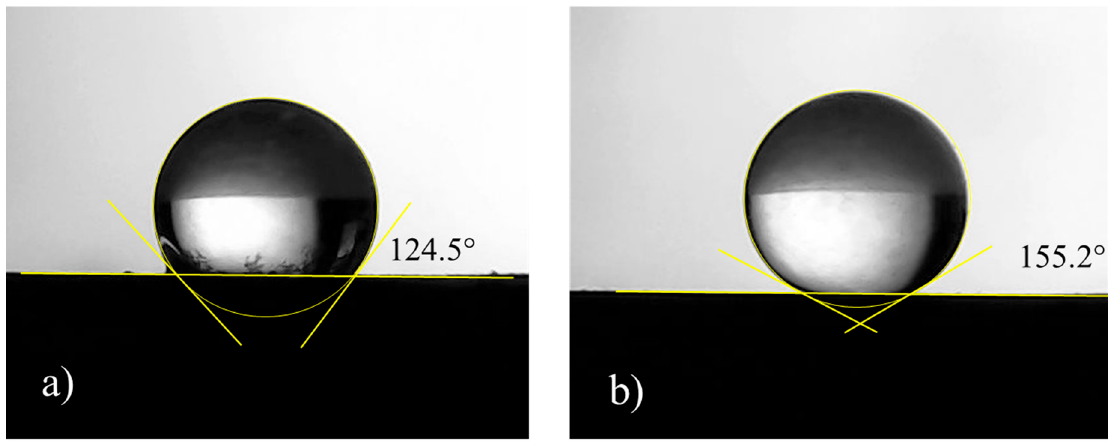
Figure 4. Schematic drawing of deposition process according to ( a ) Procedure 1 and ( b ) Procedure 2.